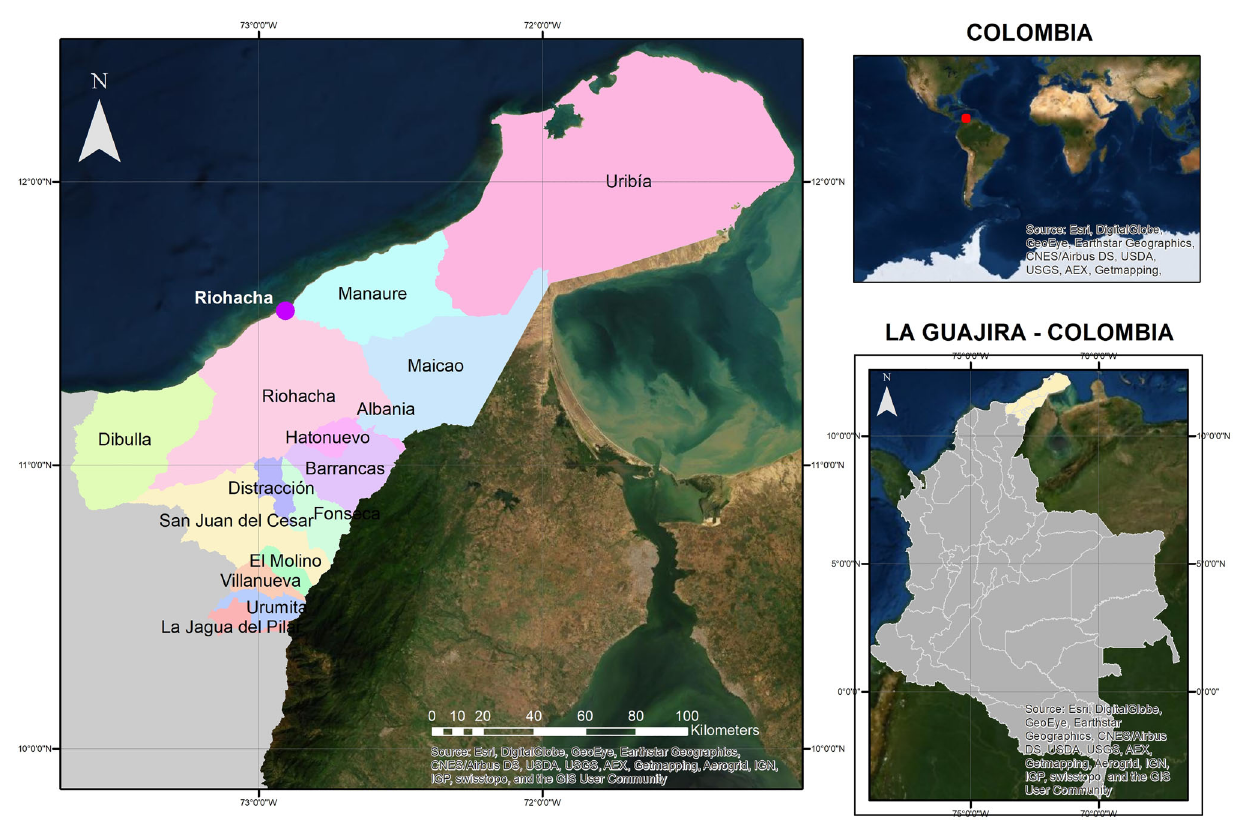
Fig. 1 Location and municipalities of La Guajira Department,